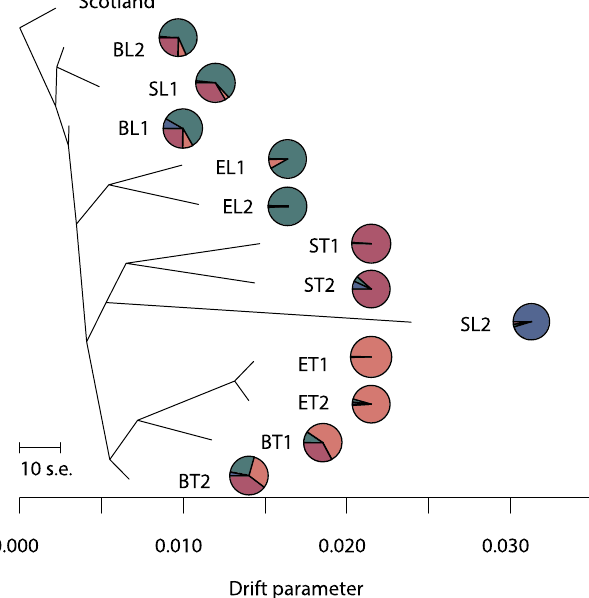
Figure 5. TREEMIX performed on 12 populations of tetraploid Cochlearia officinalis from Northern Norway, using 5,982 SNPs from the RADseq data. A population from Scotland (Aberdeenshire) was used as outgroup. Overall assignment of populations to the four STRUCTURE groups is visualized by pie charts (corresponding to Fig. 2a). Populations are named according to ecotype (B = beach, E = estuary, S = spring) and geography (T = Troms, L = Lofoten), see Table 1.